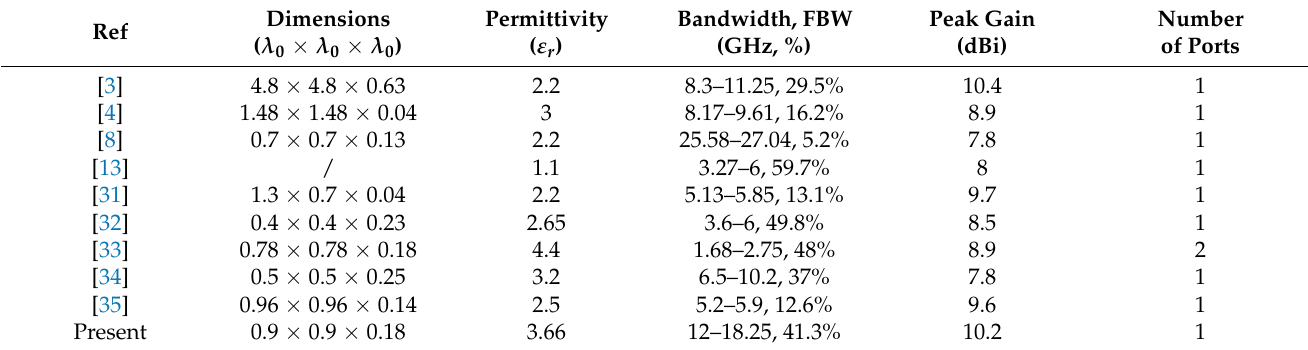
Table 1. Comparison with benchmark patch antennas.